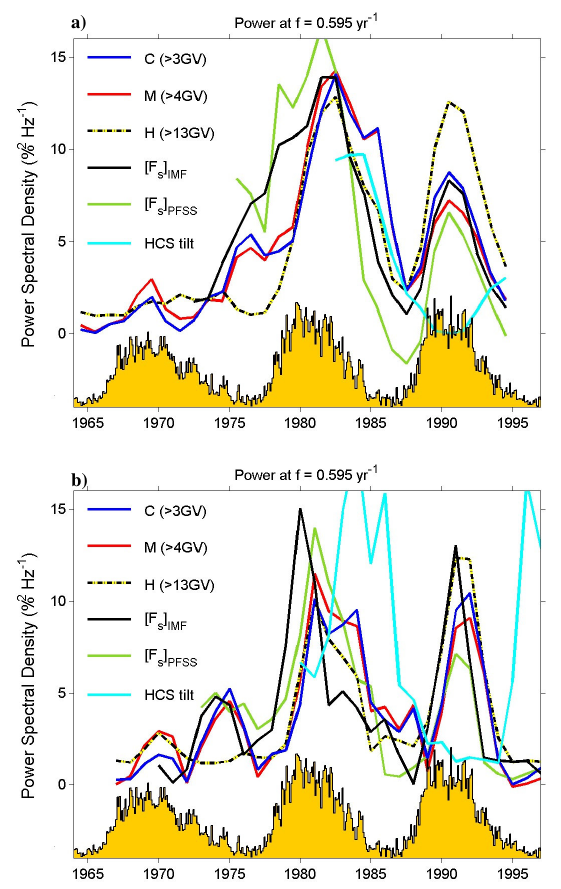
Figure 5. Time variations of the power spectral density around the period of 1.68 years (1.55yr £ T £ 1.81yr) from analysis of (top) 11-year segments of data and (b) 6-year segments of data. The variations are shown using the same line colour-coding scheme as figure 3. The sunspot number variation is shown for comparison. Power spectral densities have been scaled to that for the Climax counts, C , using the best least-squares linear regression fits of the time variations.